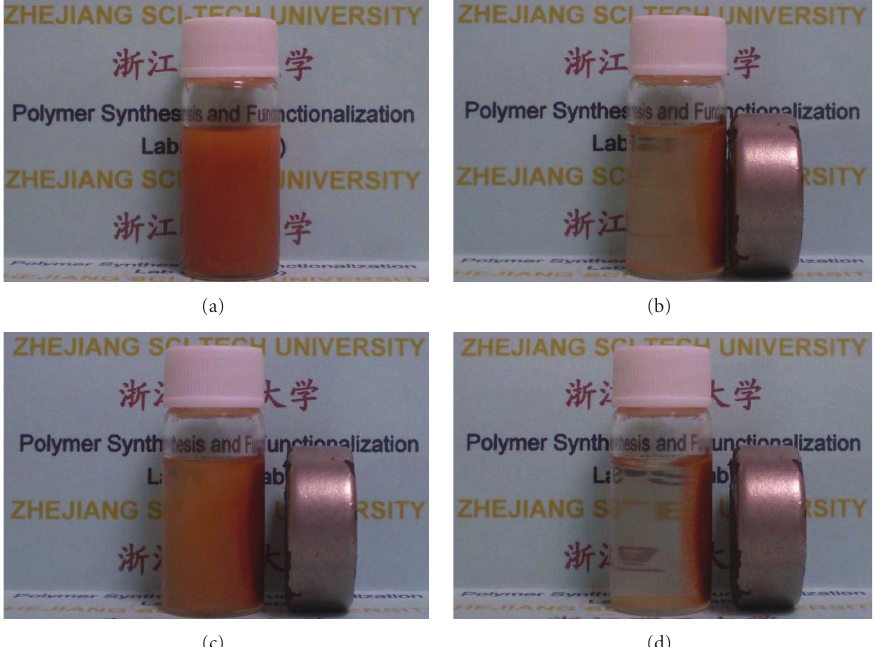
Figure 6: Digital illumination photographs of Fe 3 O 4 /SiO 2 /TiO 2 composites separated from solution by applying an added magnet ((a) 0min, (b) 1min, (c) 2min, and (d) 5min).